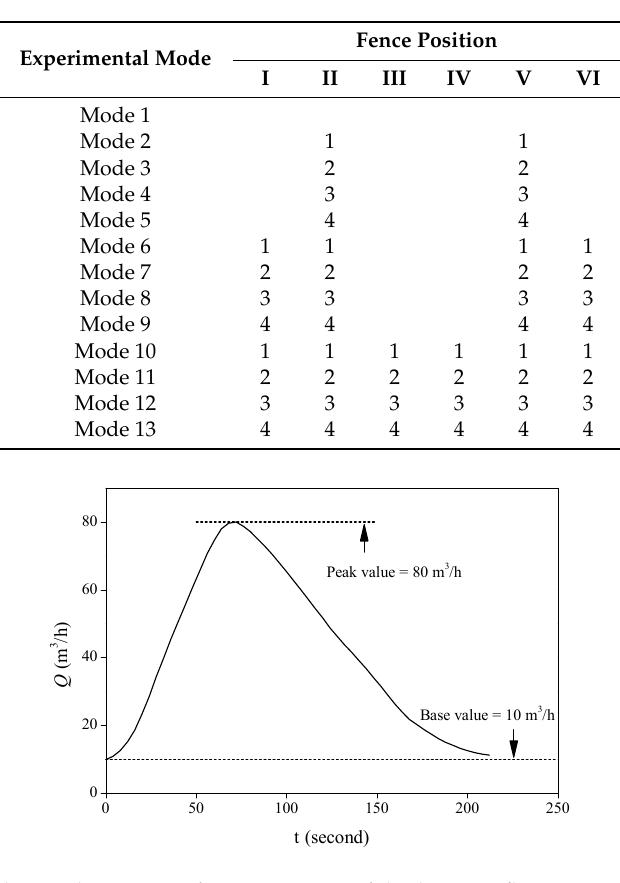
Figure 2. Hydrograph in terms of time variation of discharge at flume entrance in Exp. 2.